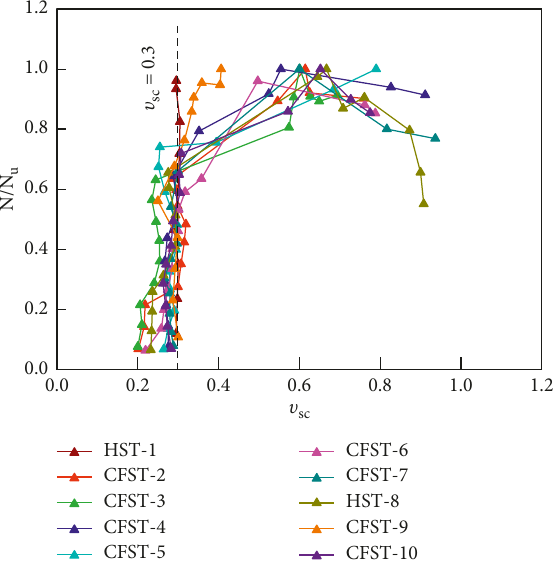
Figure 11: Poisson’s ratio of composite material load curves.